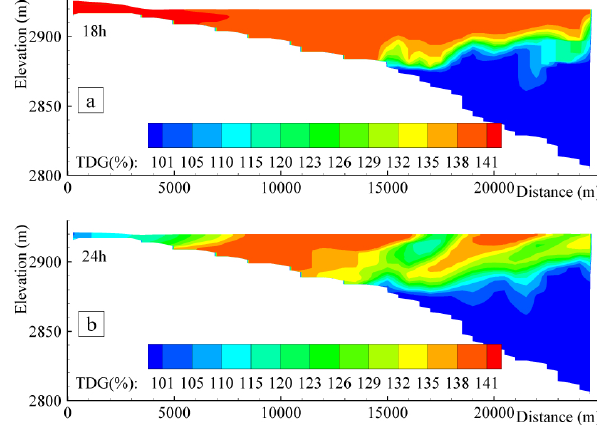
Fig. 11. Comparison of TDG distributions at the moment of accu- mulated flood discharge time of 12h ( a Case 1; b Case 2).